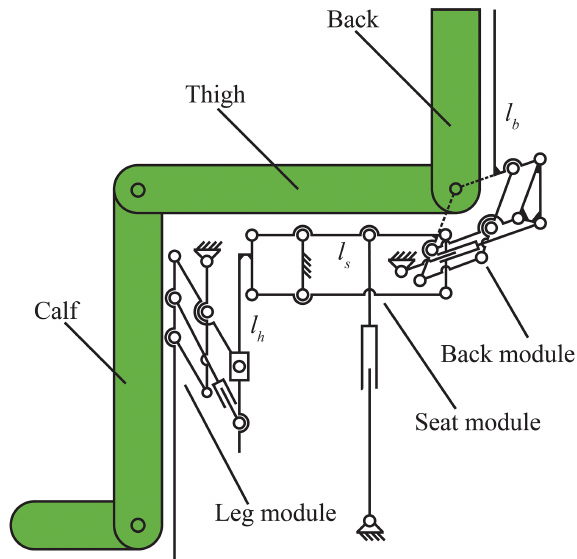
Figure 8. The overall configuration of the multi-posture wheelchair.